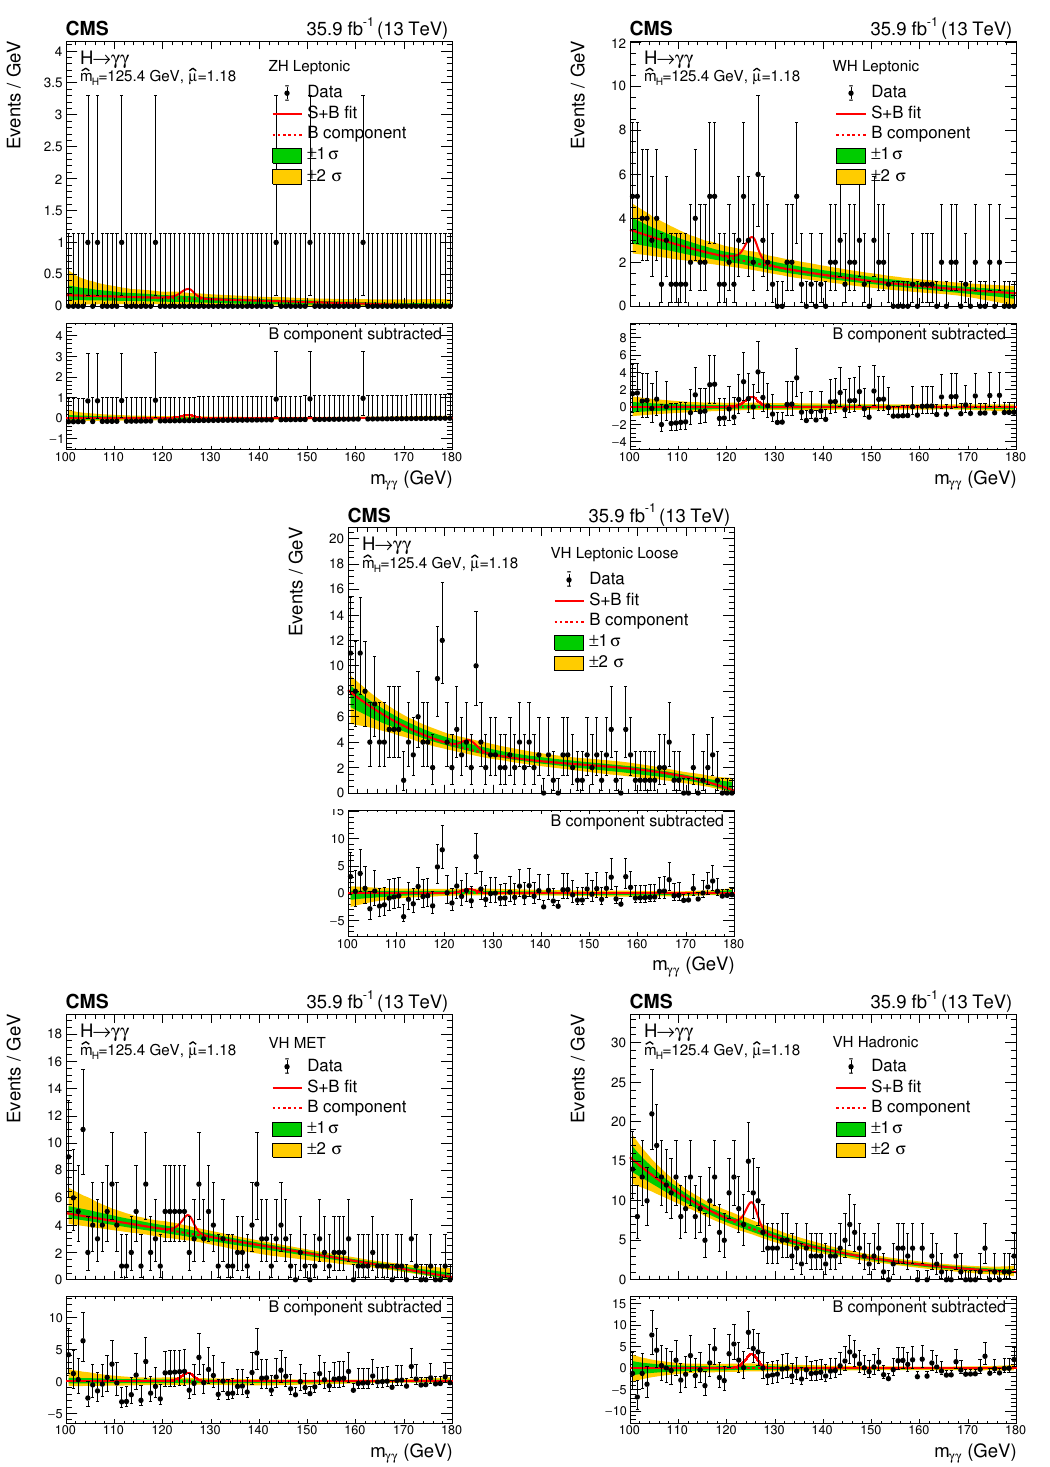
Figure 13 . Data and signal-plus-background model (cid:12)ts in VH categories are shown. The one (green) and two (yellow) standard deviation bands include the uncertainties in the background component of the (cid:12)t. The lower panel in each plot shows the residuals after the background